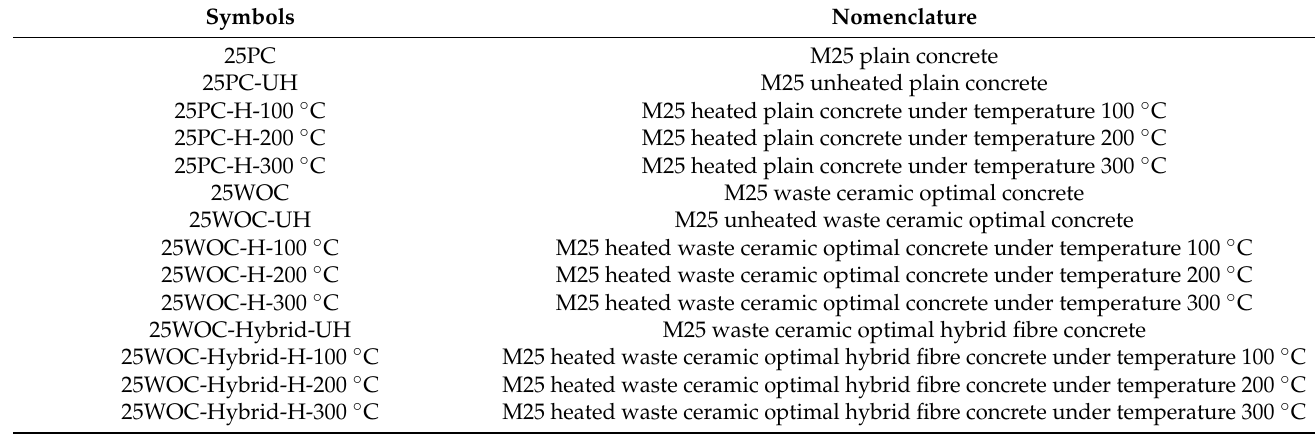
Table 4. The total used symbols in the present study.